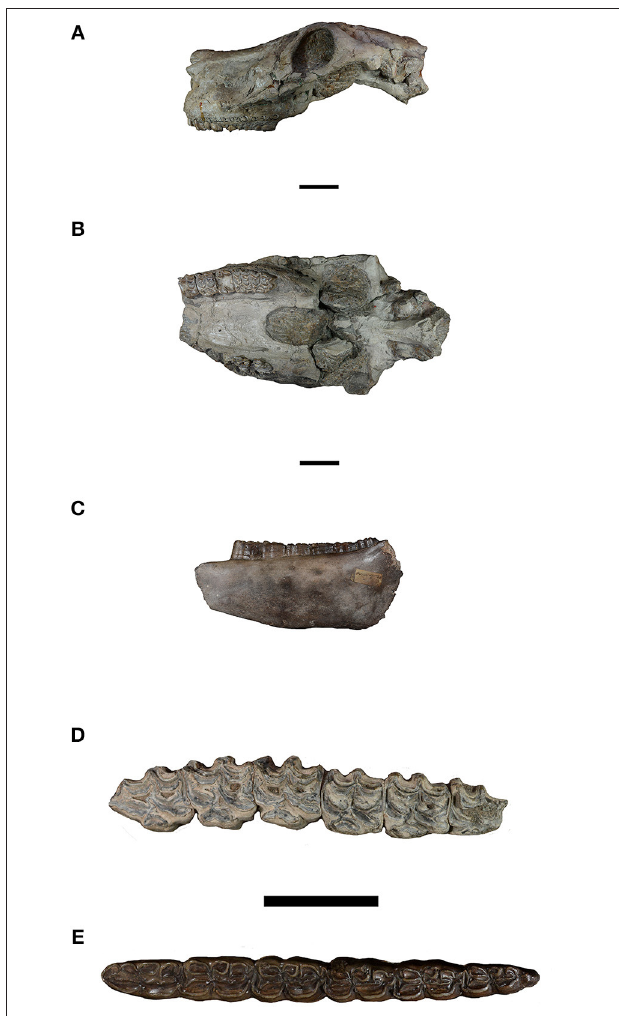
FIGURE 6 | Equus sivalensis . (A) Skull in lateral view; (B) Skull in ventral view; (C) Mandible in lateral view; (D) Upper tooth row in occlusal view; (E) Lower tooth row in occlusal